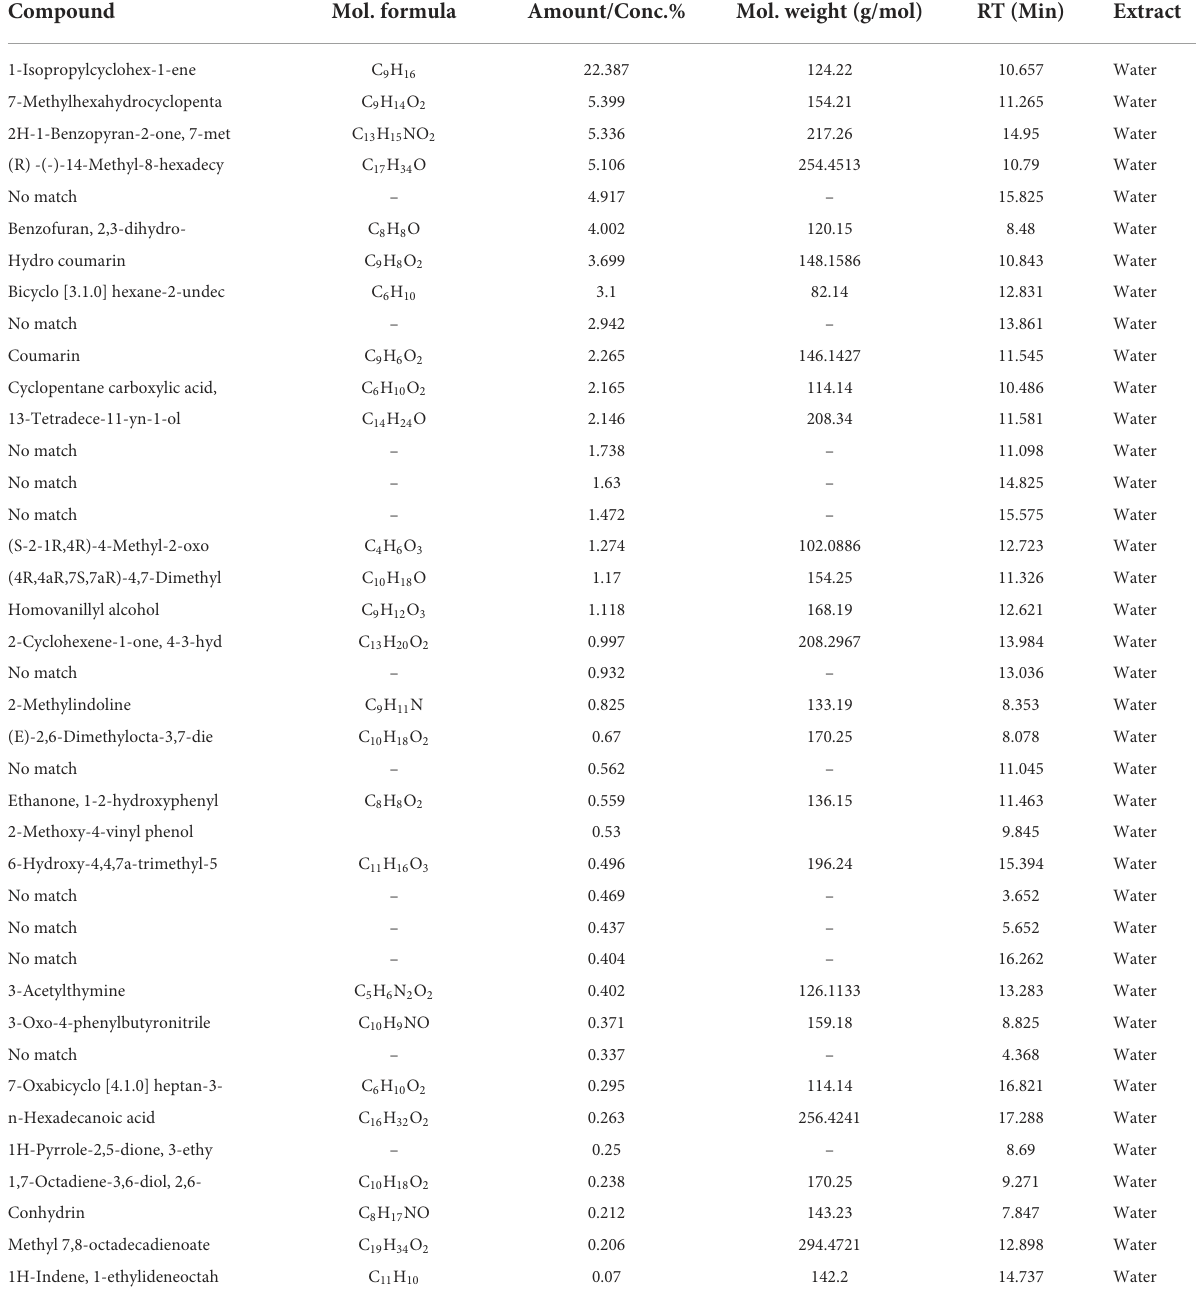
TABLE 4 GC/MS analysis of water extract of N. cataria using NIST 17 Library showed (79 identified phytochemicals + 31 unmatched) chemicals, arranged according to concentration present. Compound Mol.